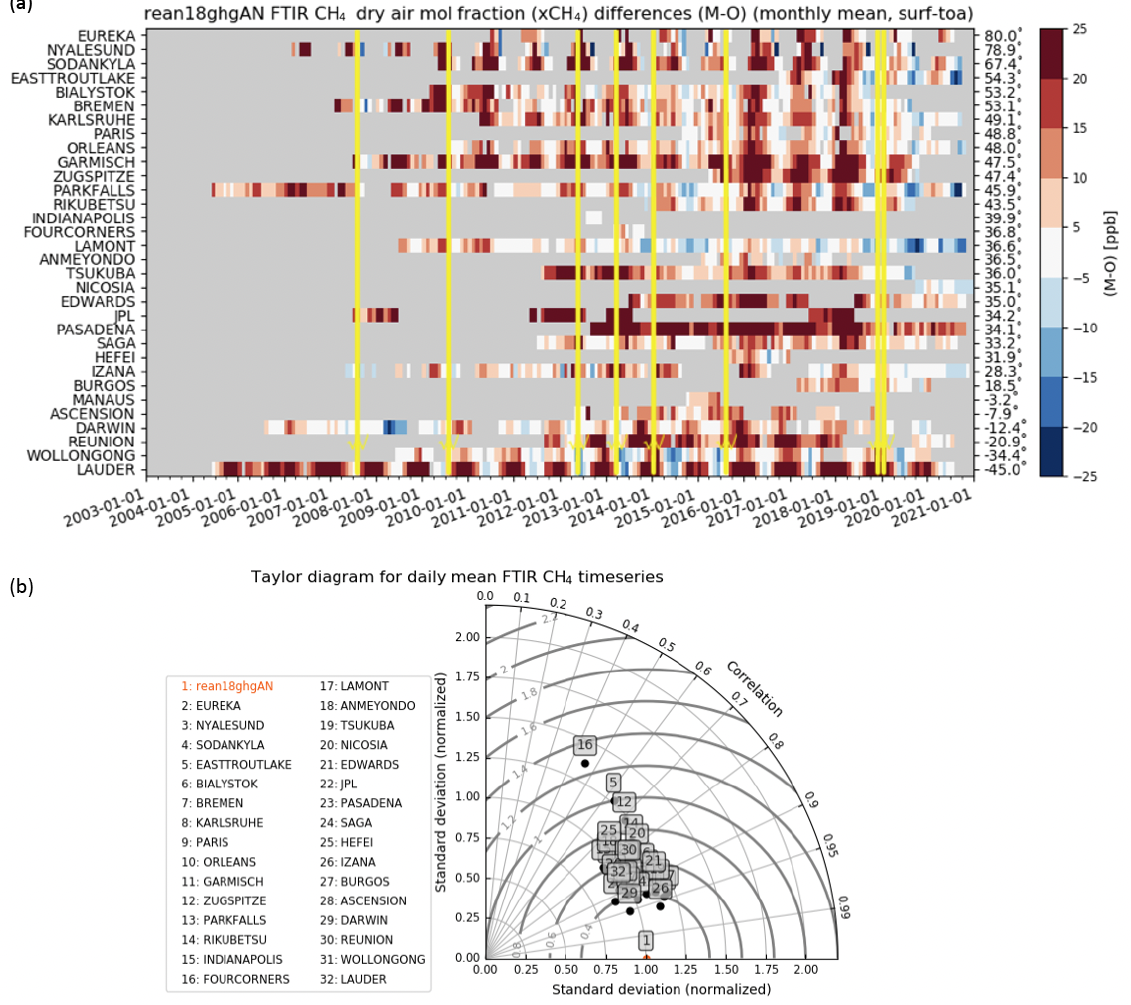
Figure 12. (a) Mosaic plot of monthly biases at all TCCON sites for the column-averaged mole fractions XCH 4 (ppb) averaged daily around local noon ( ± 2.5h). Vertical yellow lines depict the changes in the assimilated data documented in Figs. 1, 5 and 6. Grey shading indicates no observations are available. (b) Taylor diagrams for the station-dependent XCH 4 comparison of the CAMS GHG reanalysis against TCCON FTIR data. The standard deviation is normalised by dividing the observed and modelled time series by the standard deviation of the model time series. The model has higher (lower) variability compared to the observed data if the site is plotted with a distance smaller (larger) than 1 from the